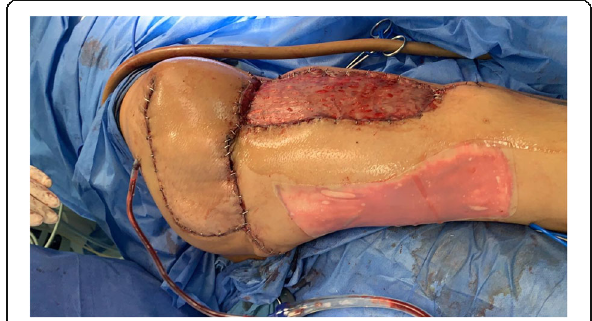
Fig. 10 Image of the patient at 14 days of recovery. Right